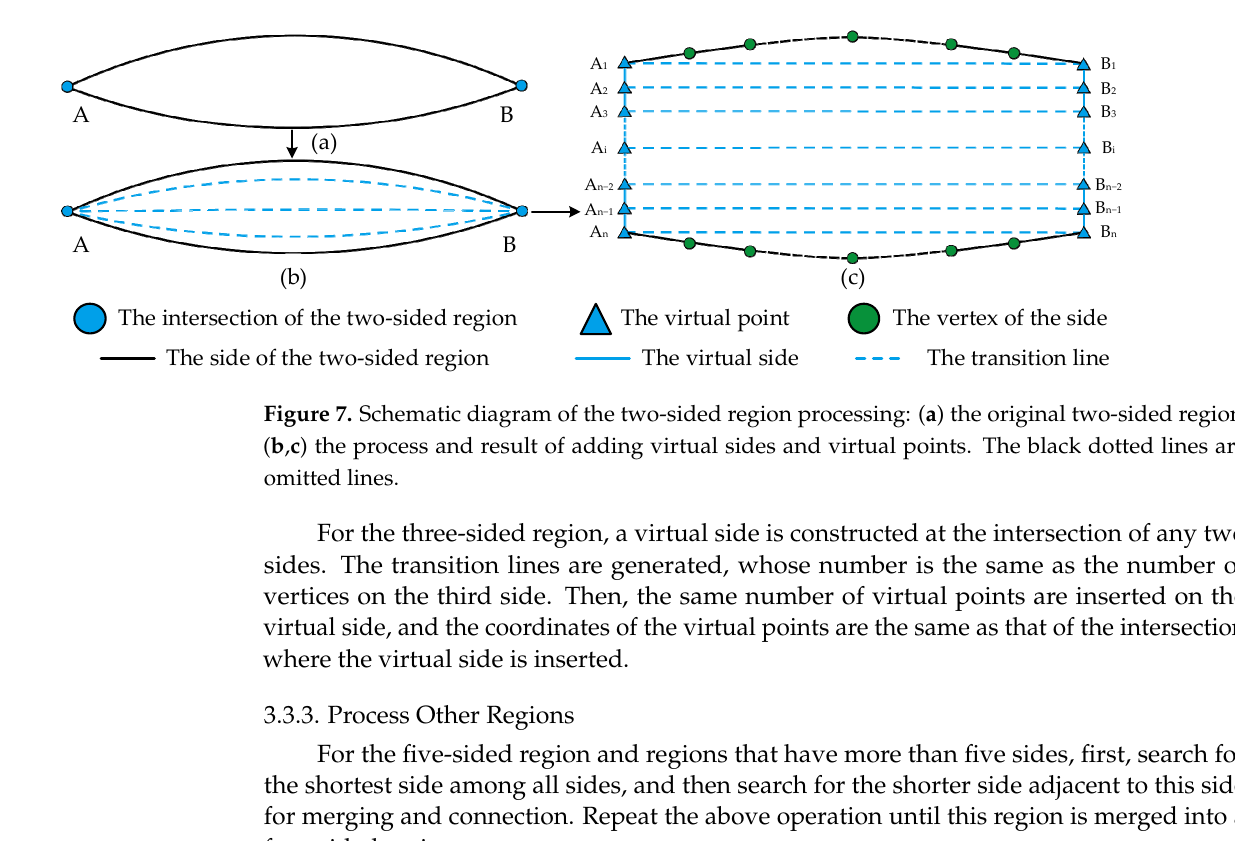
(c) Figure 6. Schematic diagram of polygon triangulation: ( a ) the original polygon; ( b , c ) the process and the result of polygon triangulation. 3.3.2. Process the Two-Sided and the Three-Sided Regions For the two-sided and the three-sided regions, we consider generating the virtual sides to transform them into four-sided regions. As shown in Figure 7, for the two-sided region, two virtual edges are generated at